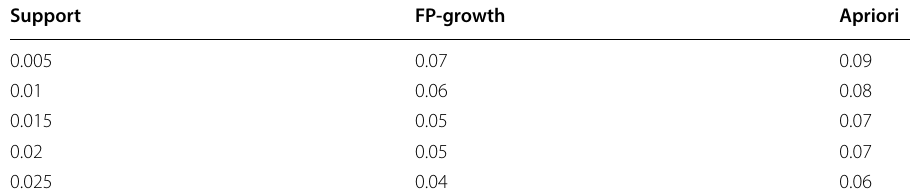
Table 5 FP-growth vs Apriori run-time